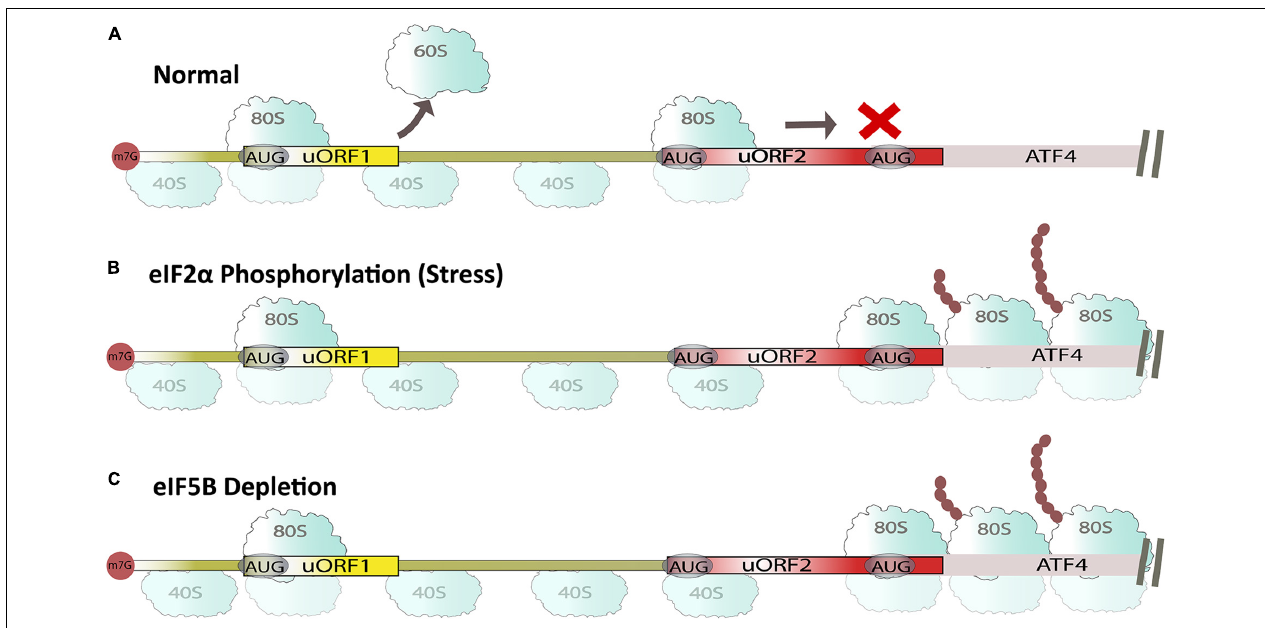
FIGURE 2 | Summary of uORF-mediated ATF4 translation. (A) Under non-aberrant normal conditions, ribosomes are recruited on uORF regions, repressing ATF4 expression in the presence of eIF5B. (B) Under aberrant stress conditions, ribosomes scan past uORF2, resulting in the synthesis of ATF4 in the presence of eIF5B. (C) eIF5B depletion in normal cells also promotes ATF4